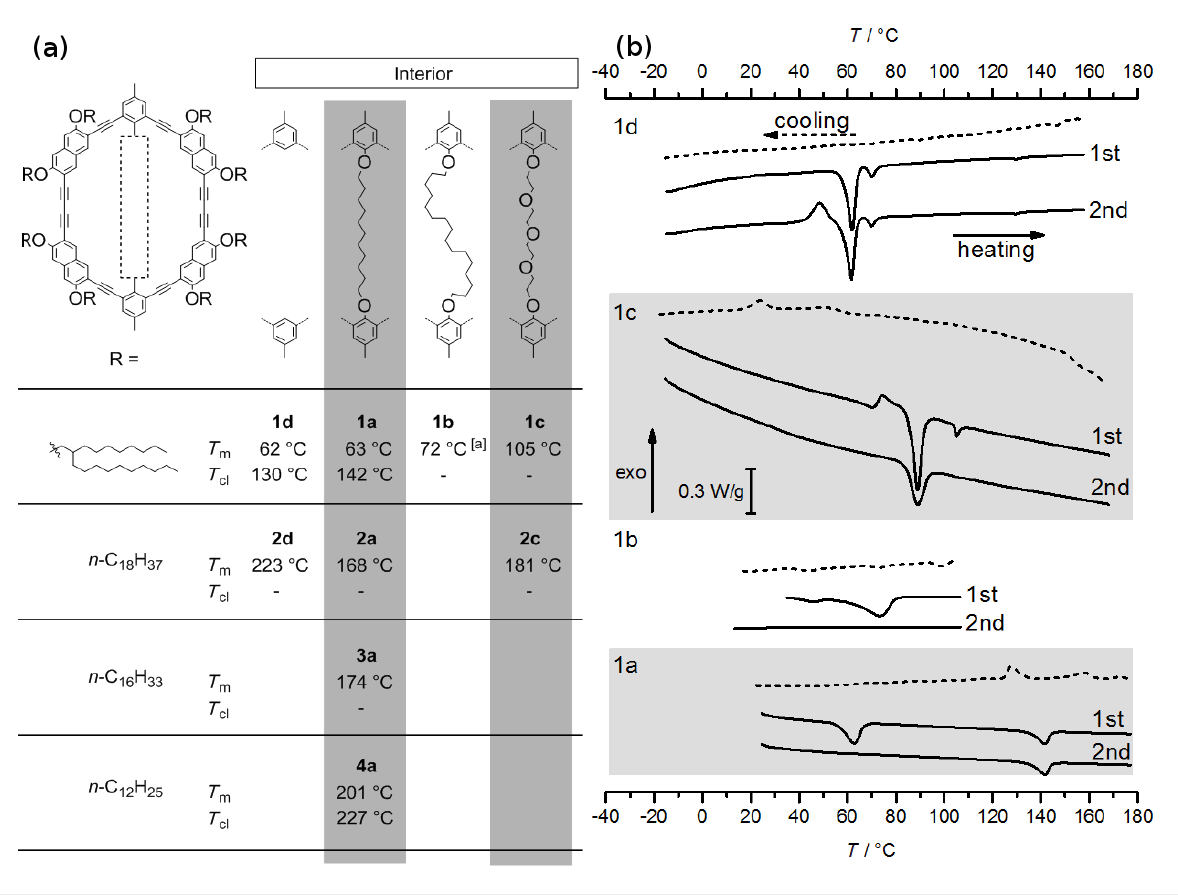
Figure 3: (a) Melting points ( T m ) and clearing points ( T cl ) of macrocycles with different interior. [a] First heating. (b) DSC heat-flux curves of 1a–d (10 K/min).